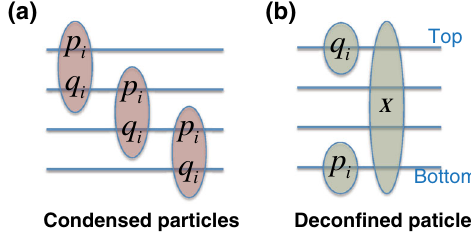
FIG. 1. (a) Each line represents a layer of a 2D Abelian topological state, and each brown circle represents a composite particle, the condensation of which will introduce the coupling between layers. Here, each composite particle lives only in two consecutive layers, and the component of the particle in the upper ’ s and q and lower layers is given by p , respectively. (b) For an i i ’ s ( p ’ s) are decon- open boundary system in the z direction, q i i fined particles on the top (bottom) surface that will form surface topological order. Depending on the choice of f p and f q , i g i g there can be deconfined particles (represented by “ X ” ) in the 3D bulk that organize themselves to form 3D topological